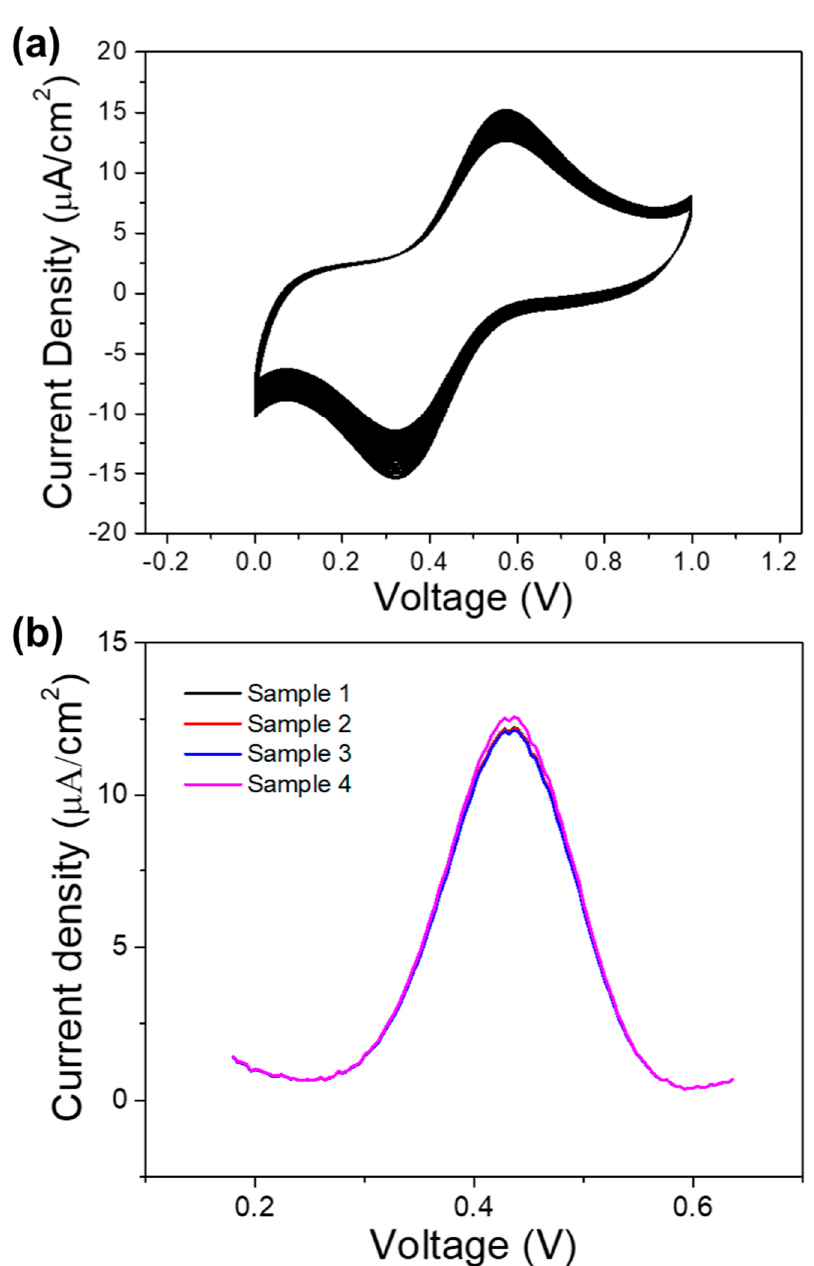
Figure 10. ( a ) CV curves of Fe 3 O 4 -modified GCE in 3 mM glucose at PBS pH 7.4 for 25 cycles ( b ) DPV curves of four different Fe 3 O 4 -modified GCE in 3 mM glucose in 0.1 M of PBS pH 7.4.